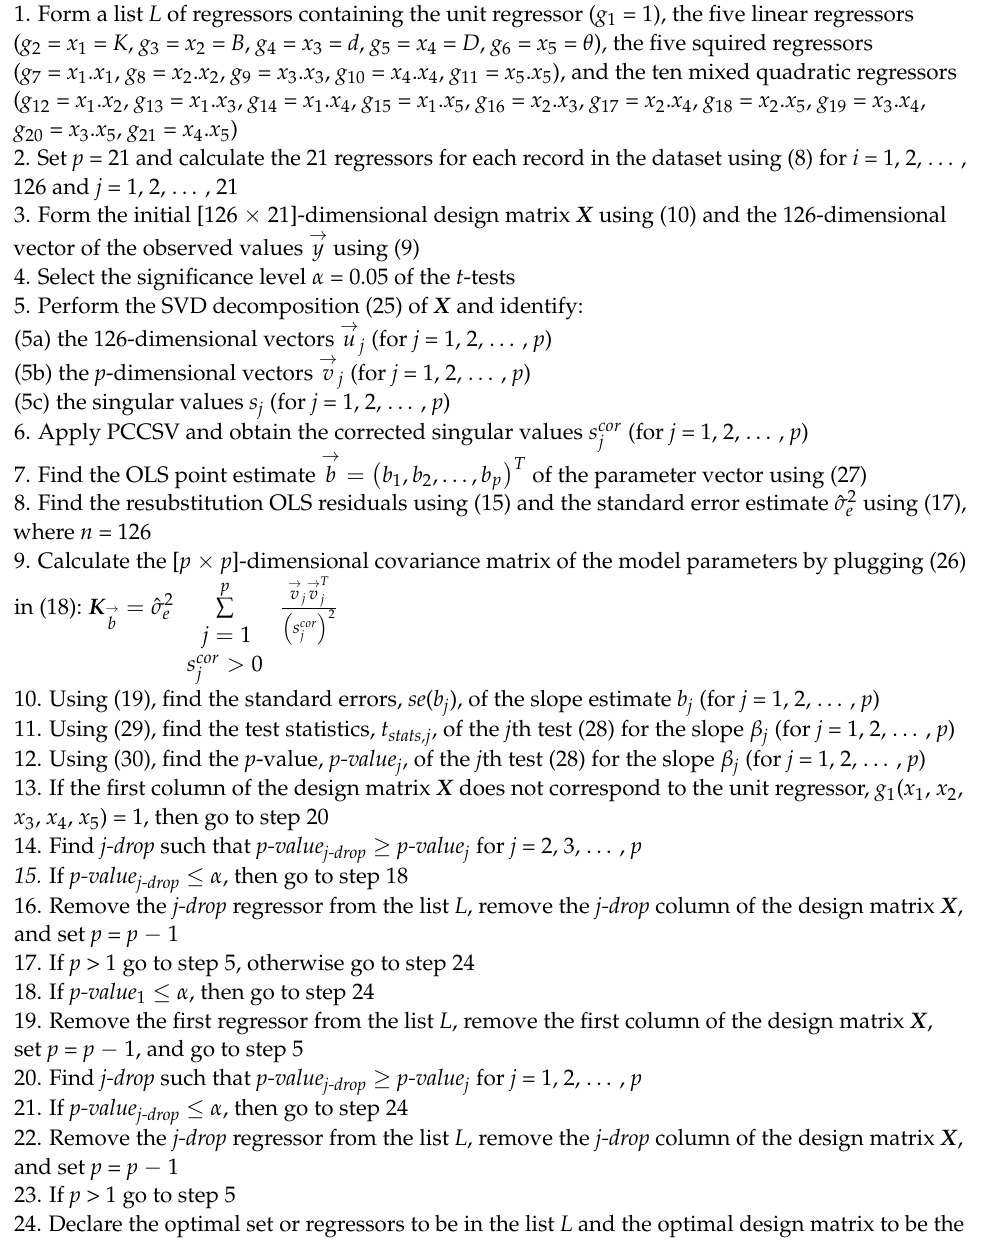
Algorithm 2: Modified stepwise regression algorithm (MSRA) for the